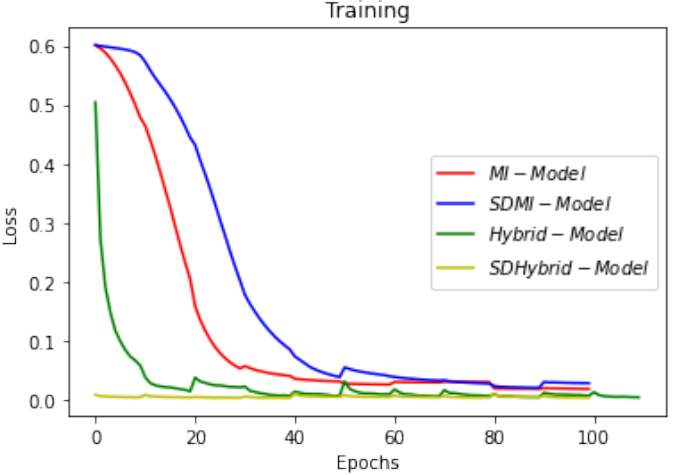
Figure 20. Comparison of Training